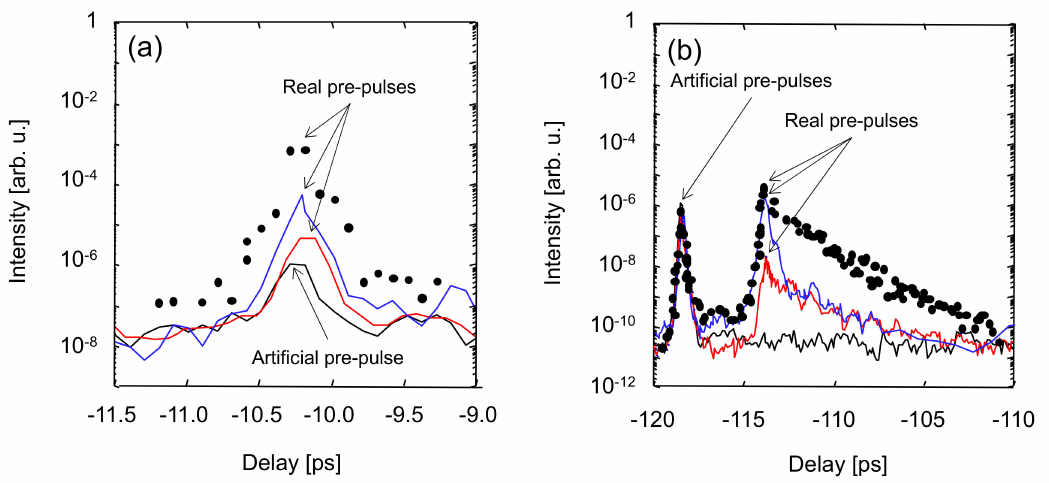
Figure 9. Measured pre-pulse contrast in the J-KAREN-P laser system with the plane-parallel plates of ~1 mm ( a ) and ~11.8 mm ( b ). The black line is for calibration (the plane-parallel plate is placed after the compressor). The red line, blue line, and black, filled circles are obtained with the output energies of ~45 mJ ~1.8 J, and ~26 J, respectively. These energies correspond to the B-integrals of ~ 0.037, ~ 0.25, and ~ 0.85 rad,